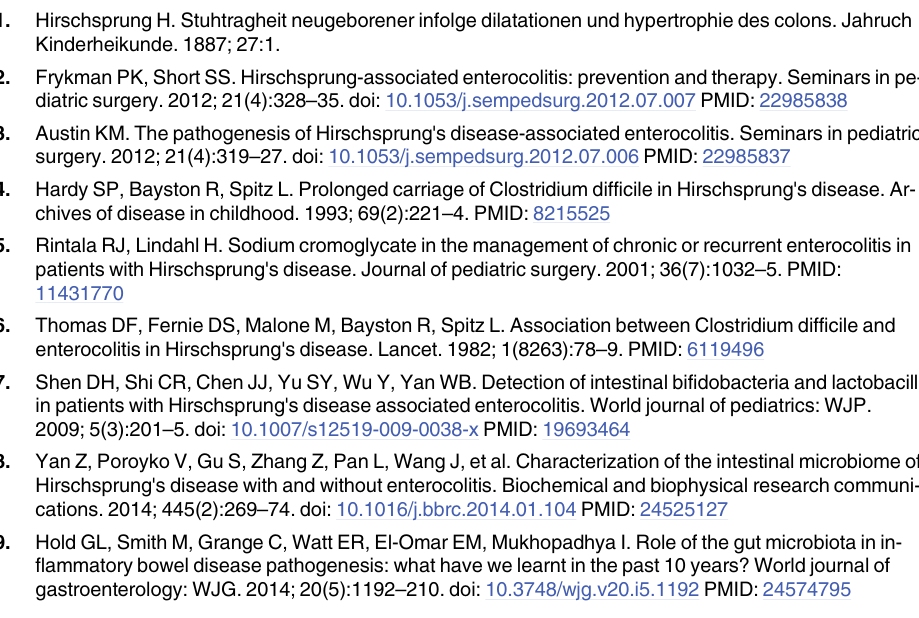
S2 Fig. Bacterial genera in HSCR and HAEC patients. A,16S rRNA gene sequence of fecal bacteria of nine HSCR patients and nine HAEC patients. The pie charts show average relative abundance of 11 major genera and subdominant genera (summarized as “ All others ” ). B, histo- grams demonstrating the genera level bacterial composition of individual subjects with HSCR and HAEC. Individual subject numbers are labeled on the X axis and expressed as relative OTU abundance per each subject. Colors were assigned for each of the 11 major genera with the scheme at the right side. S1 Table. Bacterial and fungal fecal microbiome sequence numbers in HSCR and HAEC patients. The 16S and ITS sequence numbers analyzed, including mean. S2 Table. Relative abundance of dominant bacterial genera in feces of HSCR and HAEC pa- tients. Relative OTU abundance of 16S rRNA gene sequences of fecal bacteria of nine HSCR patients and nine HAEC patients. Comparisons between HSCR and HAEC groups for each genus was performed using t-test